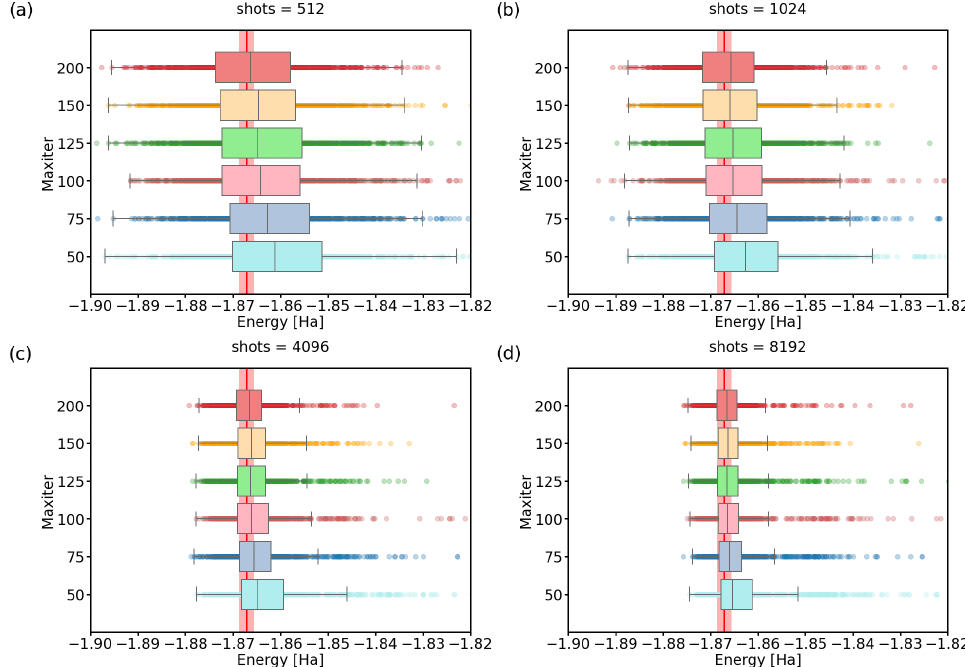
Figure 3. ( a – d ) A boxplot visualization of 1000 optimized ground-state energies for various maximum numbers of iterations of the SPSA optimizer. We performed calculations using the R y variational form. The red line represents the physical ground-state energy ( − 1.86712 Hartree) and the light-red background represents the chemical accuracy ( ± 0.0015 Hartree). The shots parameter was set to: ( a ) 512, ( b ) 1024, ( c ) 4096, ( d )